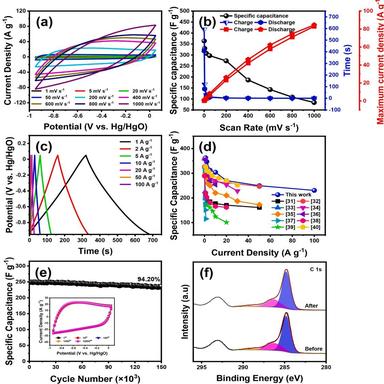
Electrochemical performances of SAPC electrode in three-electrode system, (a) CV curves at different scan rates, (b) details of CV parameters at different scan rates, (c) GCD curves at different current densities, (d) comparison of the specific capacitance of SAPC electrode at different current densities with reported porous carbon materials, (e) GCD cyclic test at 50 A g− 1 (insert: CV cyclic tests at 200 mV s − 1 ) and (f) XPS C 1 s spectra before and after GCD cyclic test.